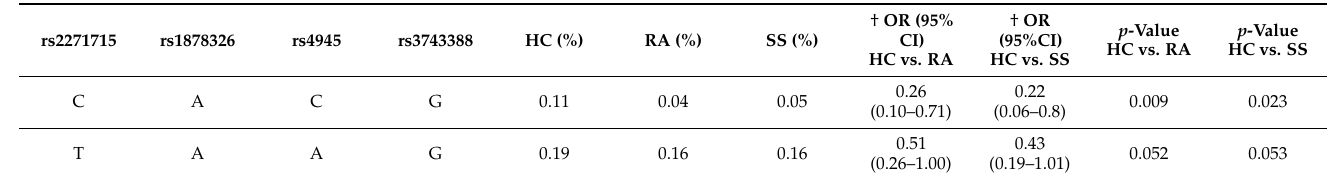
Table 1. The haplotype analysis of the MFGE8 gene variants rs2271715, rs1878326, rs4945 and rs3743388 in RA and SS patients compared to